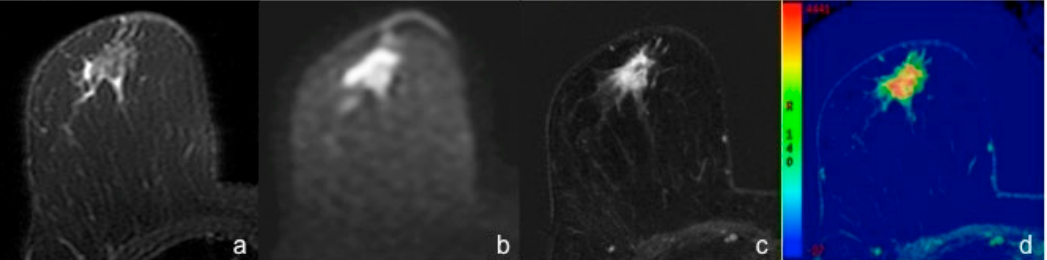
Figure 3. Breast MRI of a 57-year-old woman with IDC of the right breast (Luminal B). ( a ) Axial fat-suppressed T2-weighted image shows a hypointense irregular mass with spiculated margins and some hyperintense peripheric areas consistent with perilesional edema, in the retroareolar region. ( b ) Axial DWI image (b value = 1000 s/mm 2 ) shows the high signal intensity of the mass, corresponding to a restricted diffusion area. ( c ) Axial early post-contrast T1-weighted image and the corresponding perfusion color map ( d ) show a 16 mm irregular mass with spiculated margins and heterogeneous enhancement.